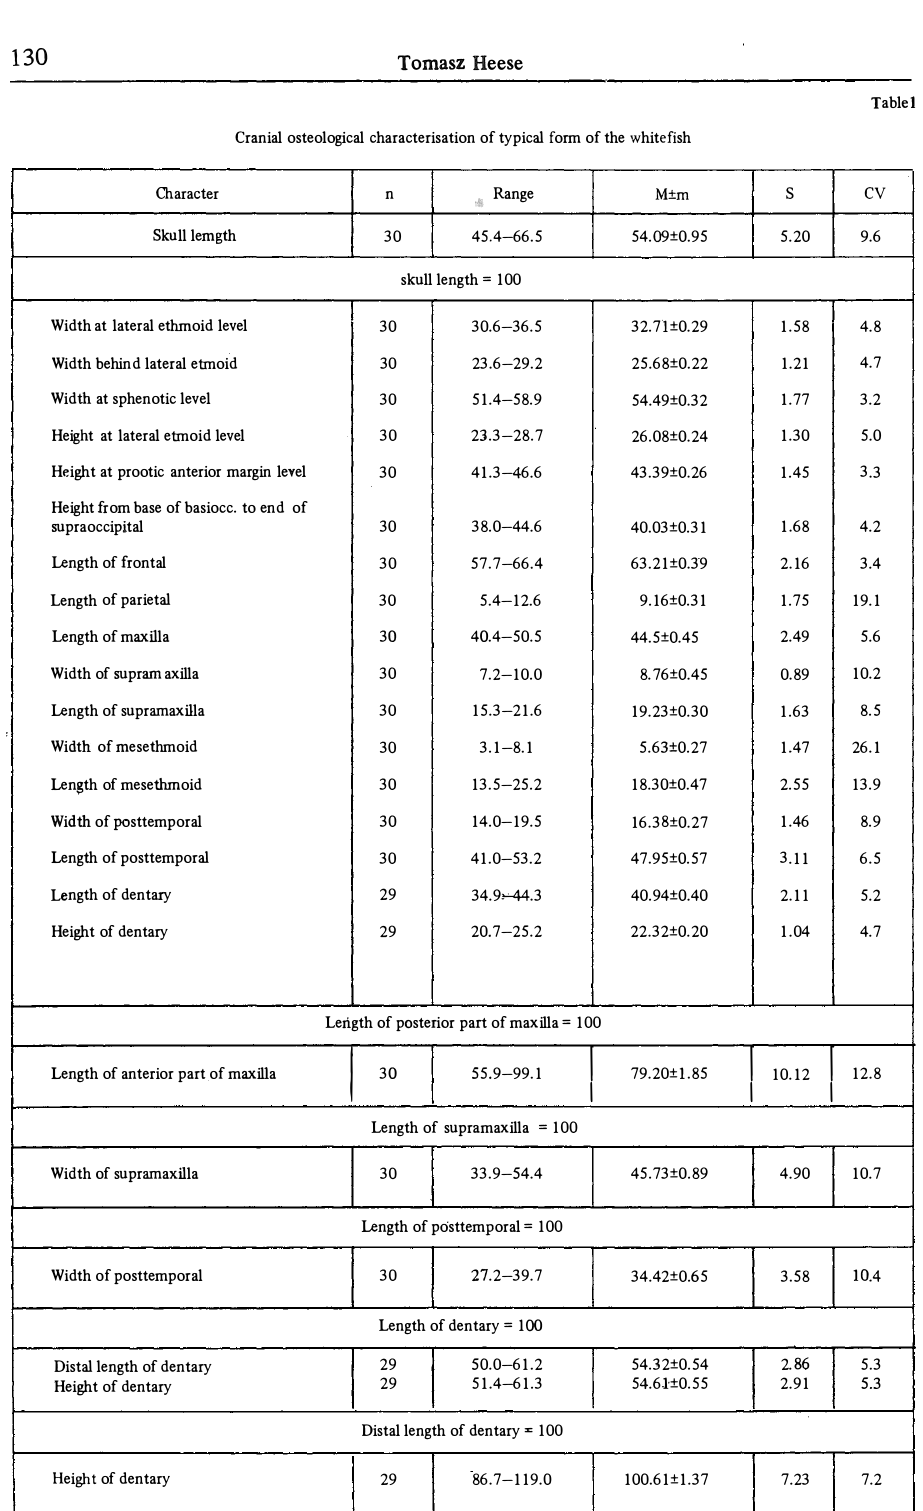
Cranial osteological characterisation of typical form of the white